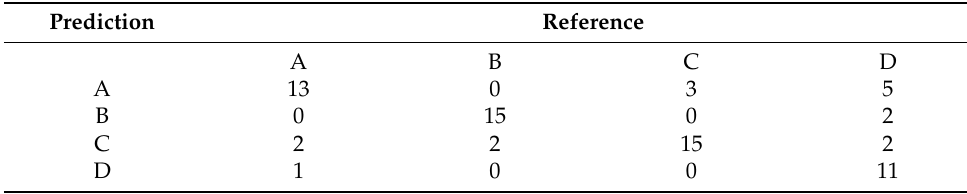
Table 6. Confusion matrix for ANN with the GA selected wave